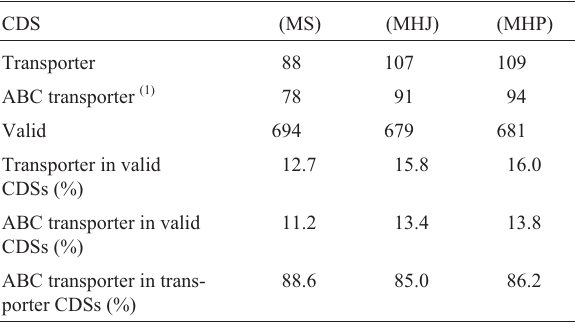
Table 1 - General transporter CDSs present in the M. synoviae strain 53 (MS)and M.hyopneumoniae strainsJ(MHJ)and7448(MHP)genomes 1